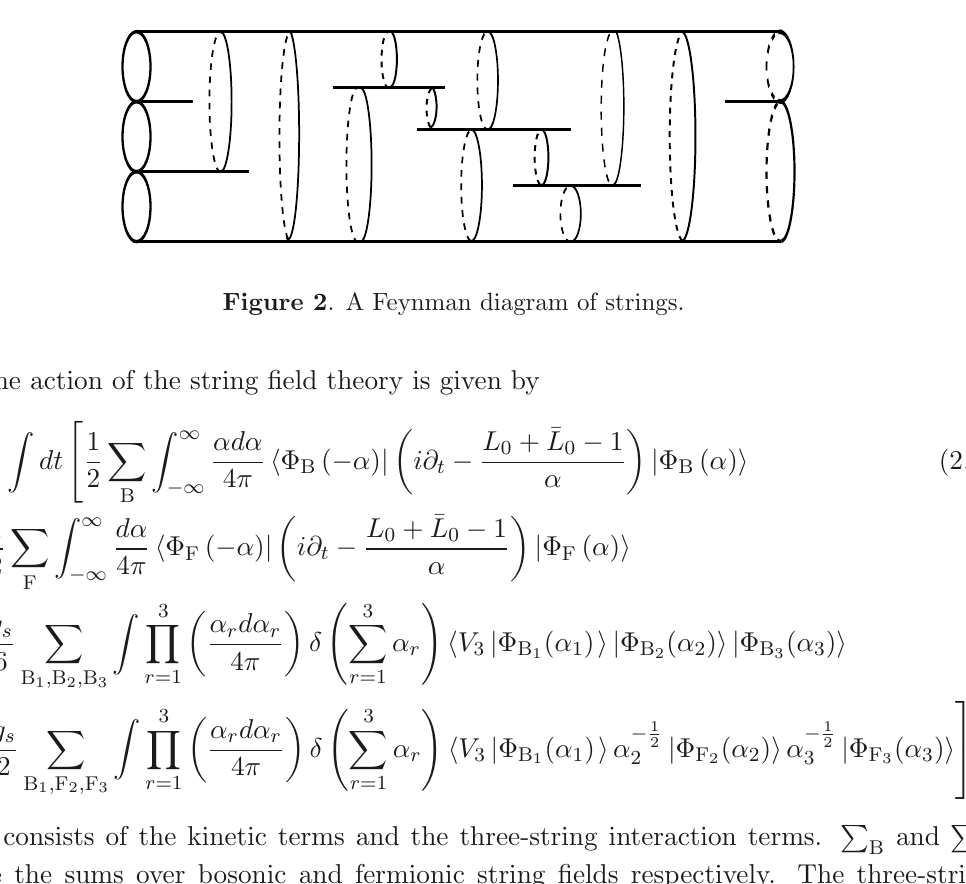
Figure 1 . The propagator and the vertex of the string field theory.